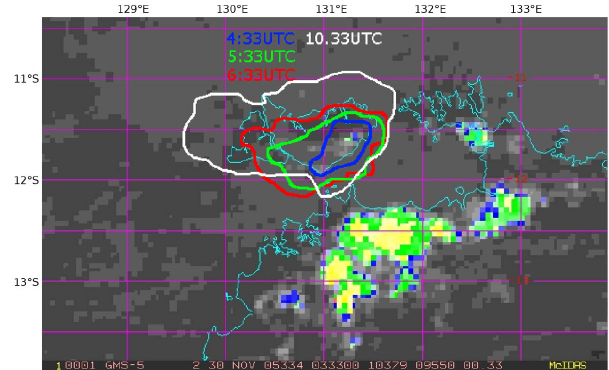
Figure 2. GMS IR cloud top temperature satellite image of the Tiwi Island region. First cloud patches of the developing Hector can be seen. The evolution of Hector is depicted with the coloured contours (see text for explanation). The satellite cloud top temperature colour scale is: > 250K grey shades, 250–230K blue shades, 230–210K green shades, 210–190K yellow shades, < 190K red shades.